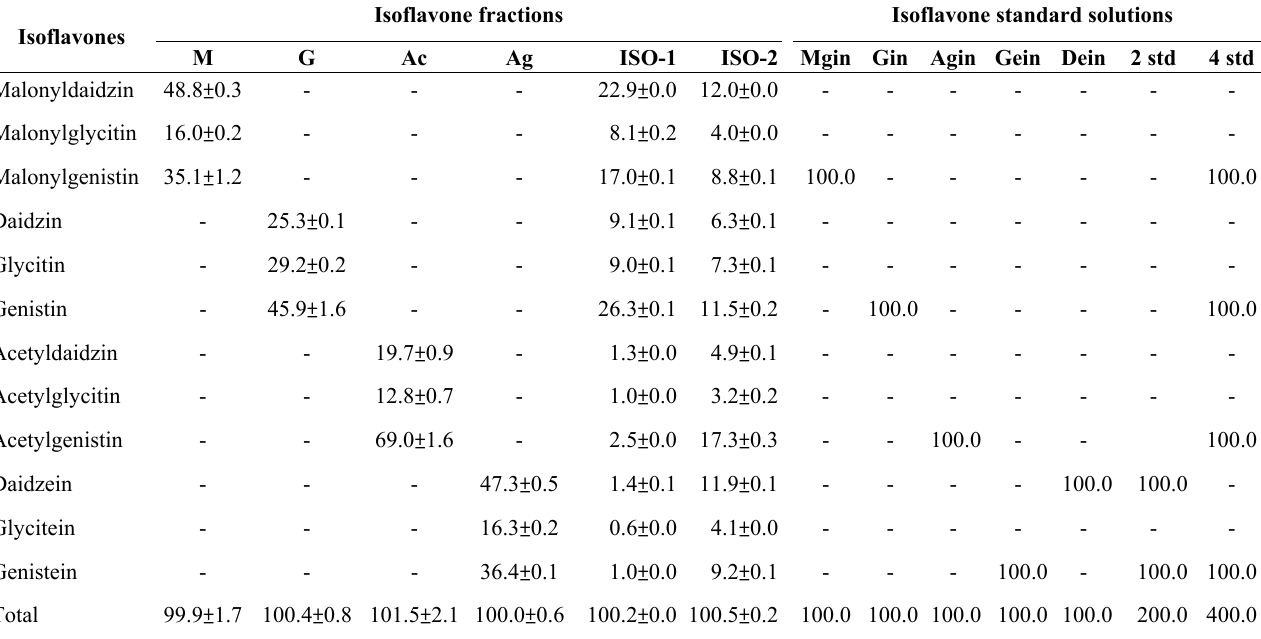
Table 1. Contents ( μ g/mL) of isoflavones in each fraction and standard